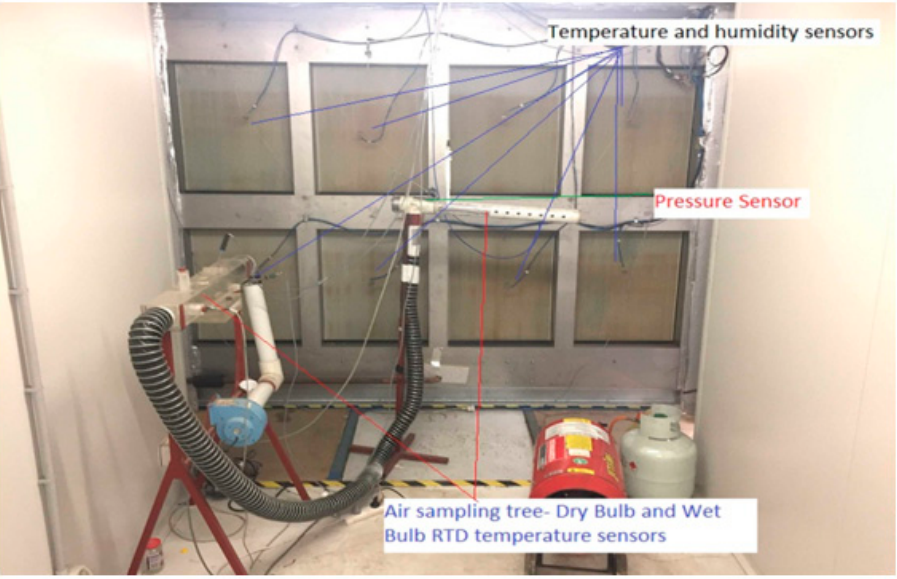
Figure 6. Inside view of the prechamber fitted with an array of sensors (photo credit: BHI-UniSA).